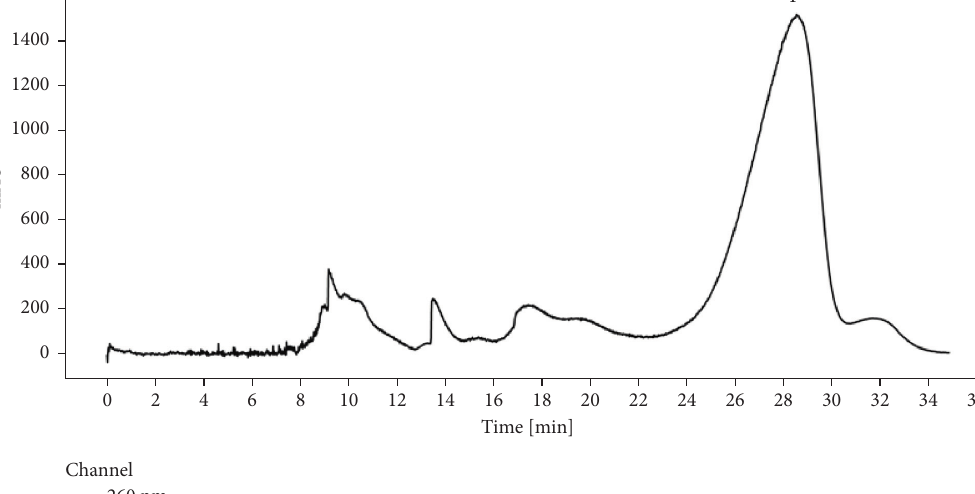
Figure 4: CPC separation of stachyspinoside 1 (peak at 28.5minutes) performed in the ascending mode (detection at 260nm). Solvent system: terAcWat +1.5_0.1%AA; sample concentration 6 mg/mL; detection wavelength 260nm; flow rate: 50mL/min; rotor speed: 1500rpm; and retention of stationary phase: